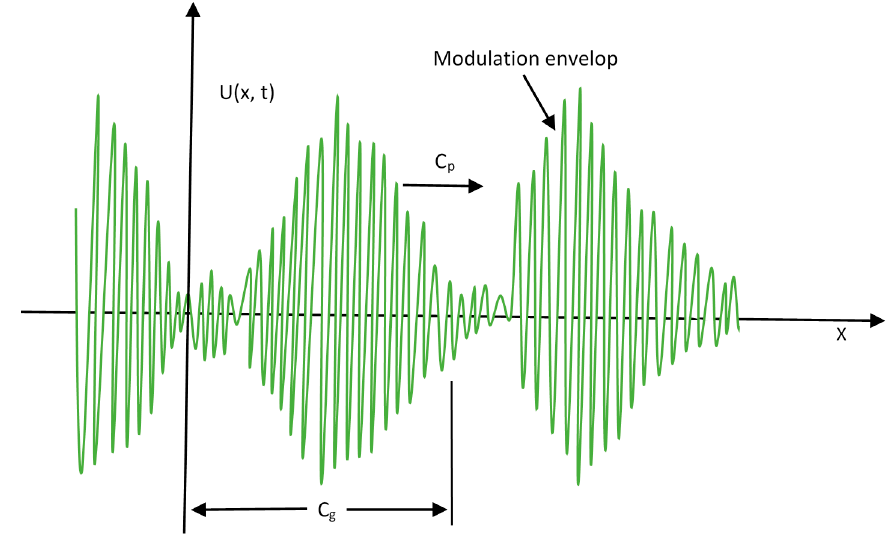
Figure 5. Phase and group velocities of GWs.